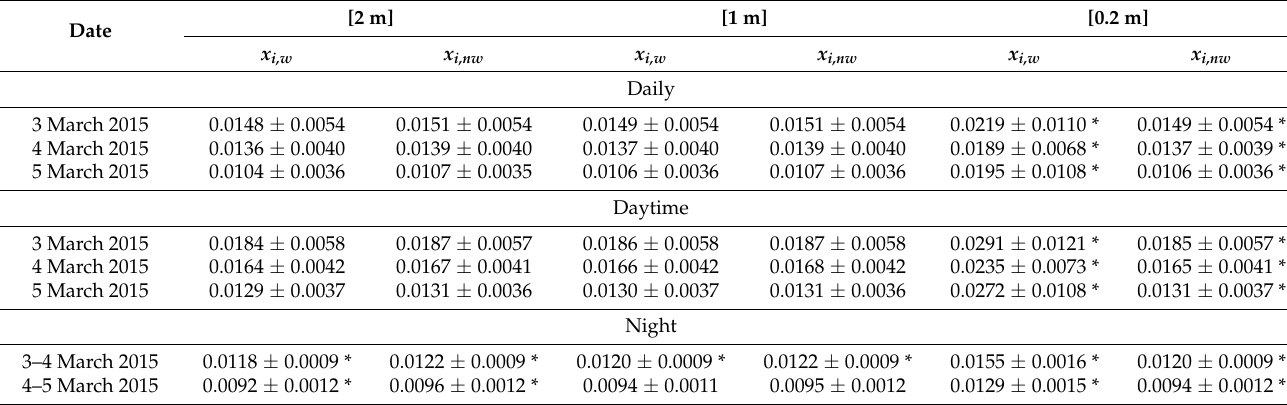
Table 4. Absolute air humidity inside the greenhouse, x i [g g − 1 ] [average value ± standard deviation]. Subscripts: w , with low tunnel; nw , without low tunnel. Heights of air temperature measurements: two meters [2 m]; one meter [1 m] and zero point two meters [0.2].